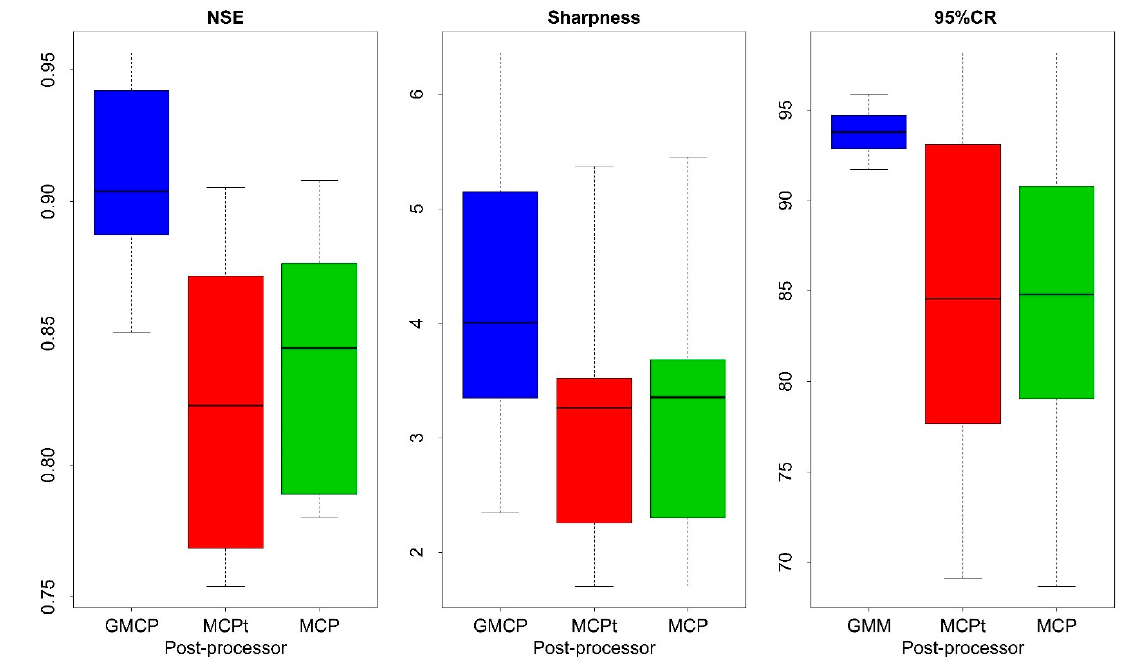
Figure 4. Performance of monthly predictions in terms of NSE, sharpness, and containing ratio